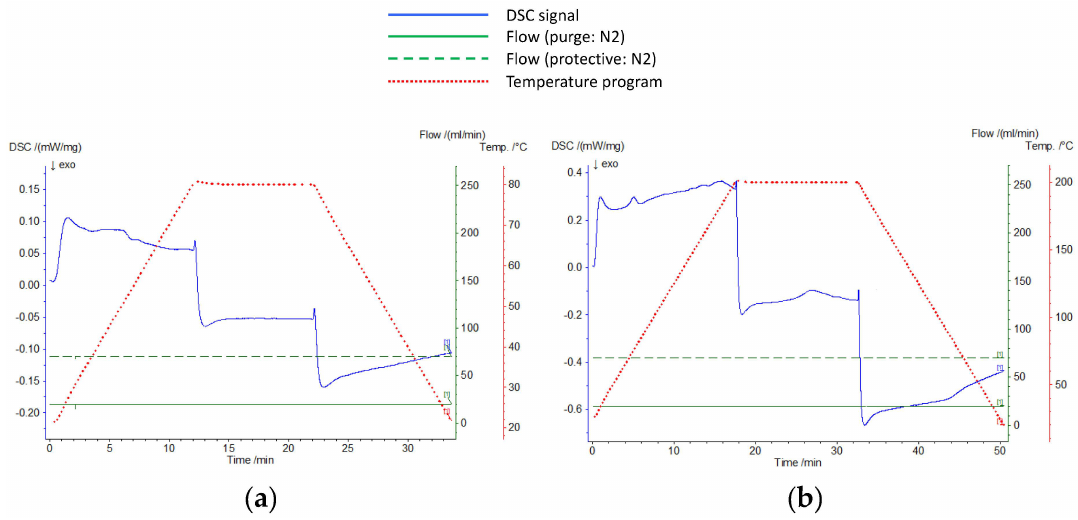
Figure 4. Melting and solidification curve of polymers tested. ( a ): polystyrene; ( b ): acrylic.